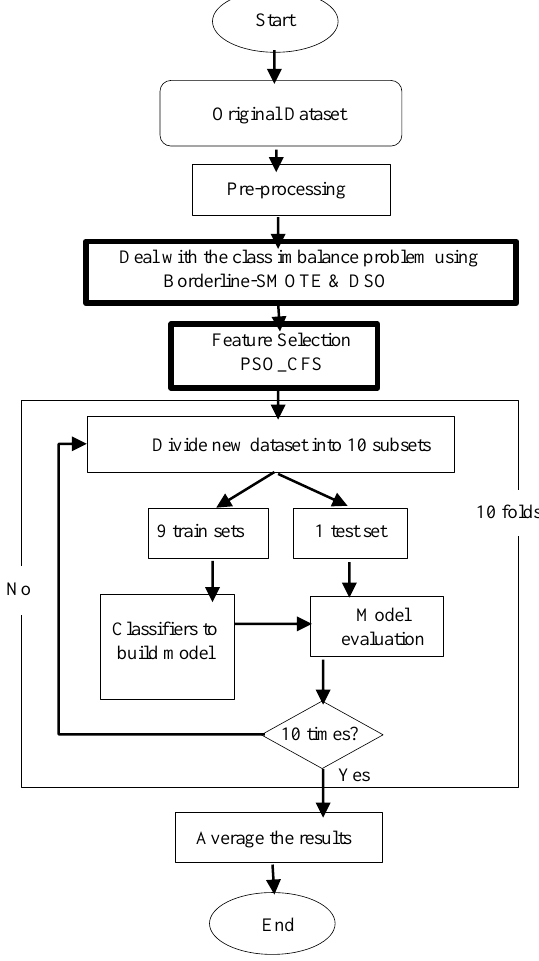
Figure 1. Flowchart of proposed